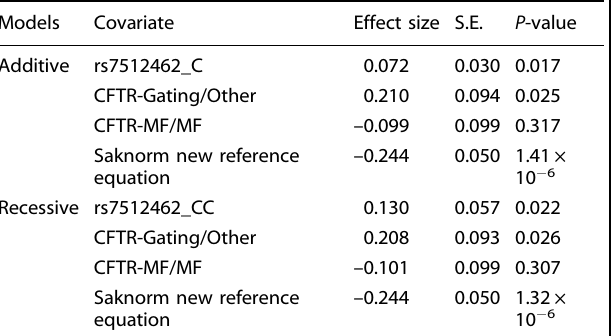
Table 2. Association between Saknorm and rs7512462 using additive and recessive codings in the CGMS prior to treatment.